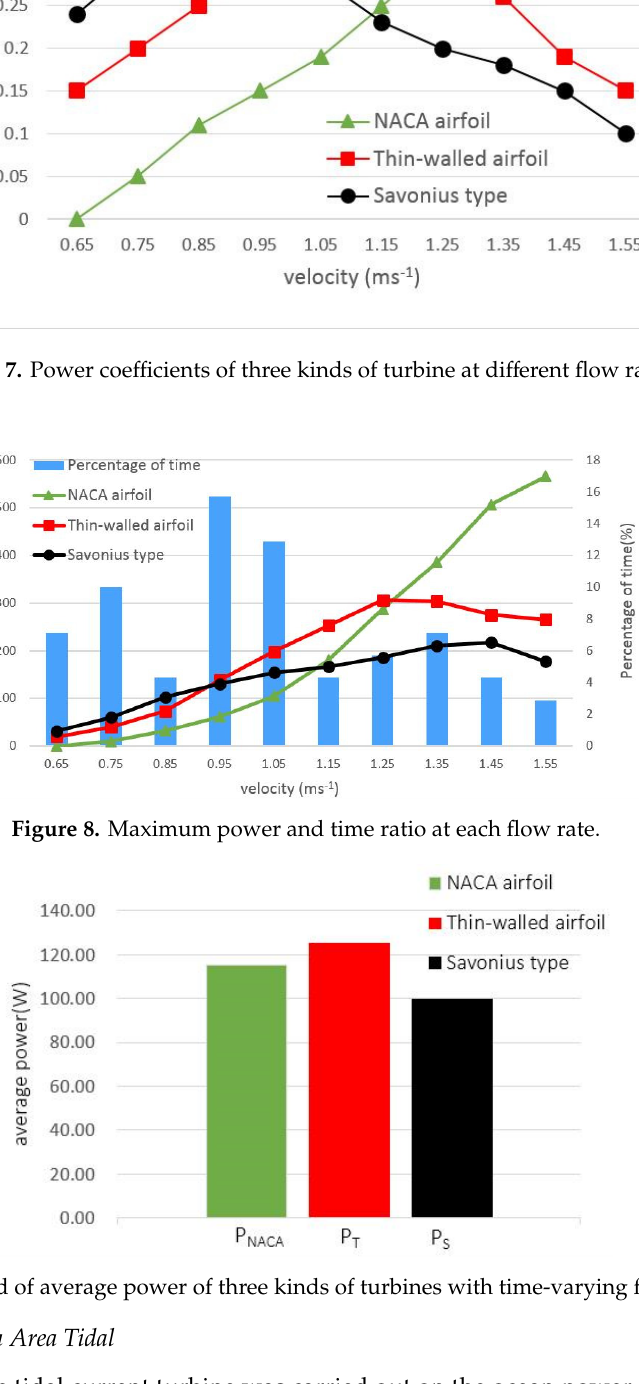
Figure 7. Power coefficients of three kinds of turbine at different flow rates.